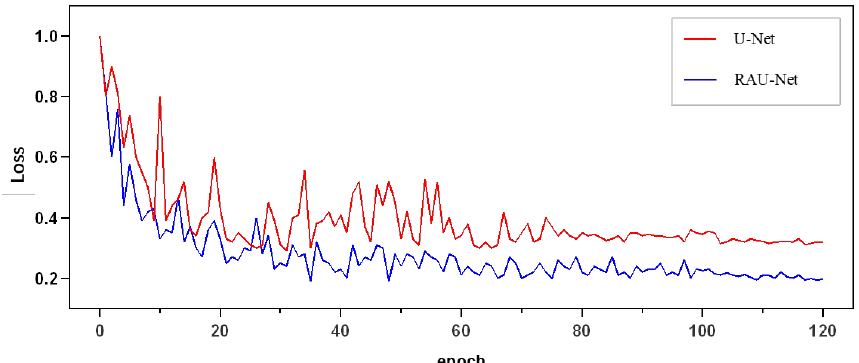
Figure 6. Variation in the loss value on the verification set of two networks.